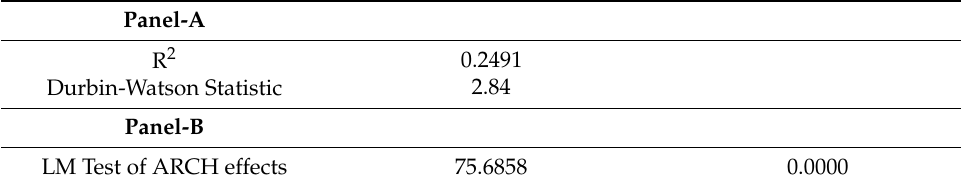
Figure 3. The diagram shows the correlograms of squared residuals. We use data of 197 stocks listed on S&P/ASX200 from 27 January 2020 to 30 December 2020 to examine the effect of COVID-19 on Australian stock returns and their volatility. VWR-ASX200 is the value-weighted return of 197 stocks listed in S&P/ASX200 at level, Oil Price is the international crude oil price to the order I(1), the Interest rate is Australian one-month interbank interest rate to the order I(1), COVID-19A represents the total number of confirmed cases in Australia due to COVID-19 to the order I(1), COVID-19B represents the total number of deaths in Australia due to COVID-19 to the order I(1) and COVID-19C is a dummy variable depicting the negative news, and it takes a value of 1 from 24 February 2020 to 22 March 2020 otherwise 0. Table 4. Panel A shows the values of R 2 taken from regression output and Durbin-Watson statistic (DW) fetched after running the regression. A comparison of these shows that DW statistic > R 2 . Panel B presents the Breusch test for heteroskedasticity and the LM Test to observe the ARCH Effect. In the heteroskedasticity test, the null hypothesis for homoskedasticity is rejected in favour of heteroskedasticity. In the ARCH effect, the null hypothesis for no ARCH effect is rejected in favour of the presence of ARCH effects. We use data of 197 stocks listed on S&P/ASX200 from 27-01-2020 to 30-12-2020 to examine the effect of COVID-19 on Australian stock returns and their volatility. VWR-ASX200 is the value-weighted return of 197 stocks listed in S&P/ASX200 at level, Oil Price is the international crude oil price to the order I(1), the Interest rate is Australian one-month interbank interest rate to the order I(1), COVID-19A represents the total number of confirmed cases in Australia due to COVID-19 to the order I(1), COVID-19B represents the total number of deaths in Australia due to COVID-19 to the order I(1) and COVID-19C is a dummy variable depicting the negative news, and it takes a value of 1 from 24-02-2020 to 22-03-2020 otherwise